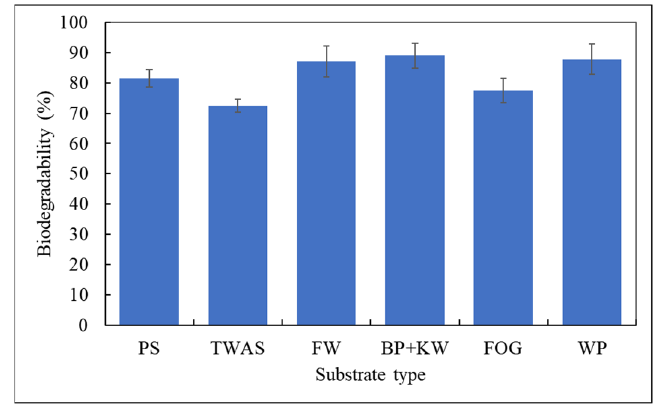
Figure 7. Biodegradable fractions for all the different substrates.